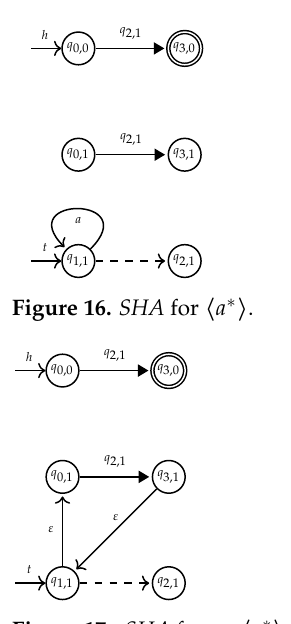
Figure 17. SHA for µ a .